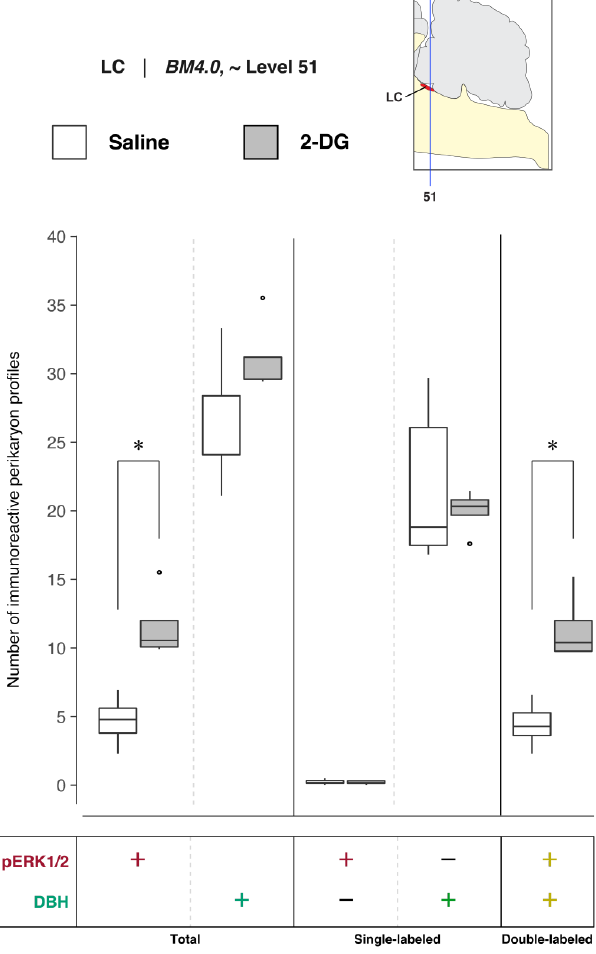
Figure 4. Increased recruitment of locus ceruleus (Wenzel and Wenzel, 1812) (LC) [82] neurons 15 min after 2-DG administration. Abercrombie-corrected [106] perikaryon profile counts from both saline- and 2-DG-treated subjects are represented as box plots displaying the total numbers of phospho- ERK1/2- or DBH-immunoreactive profiles, or only the single- and double-labeled profiles, from tissue sections identified to be in register with BM4.0 atlas level 51 (map, upper right ). An asterisk (*) denotes statistical significance between groups, FDR-adjusted p < 0.05. See Tables S1 and S2 for details. On the box plots, potential outliers are presented as open circles.